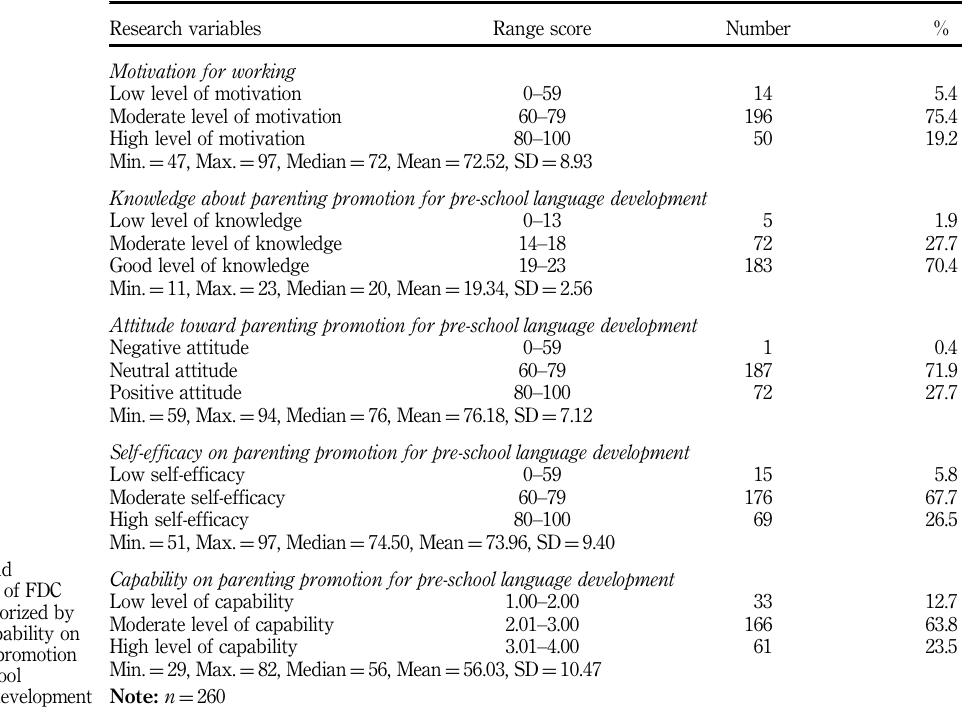
percentage of FDC staff, categorized by level of capability on parenting promotion for pre-school language